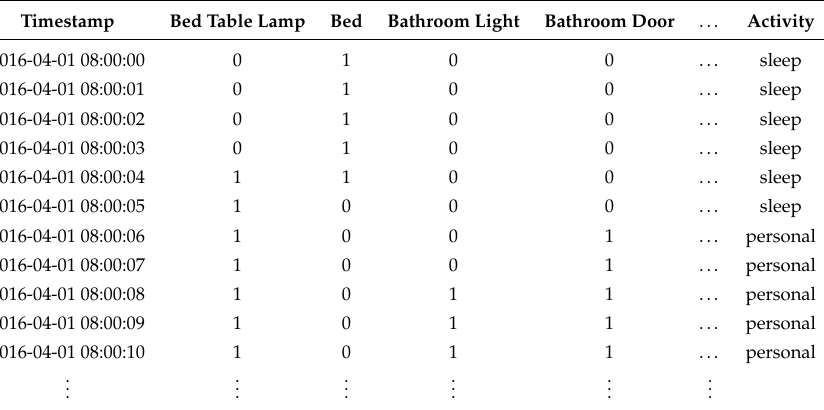
Table 4. A sample of the final dataset output. Bed Table Lamp Bed Bathroom Light Bathroom Door